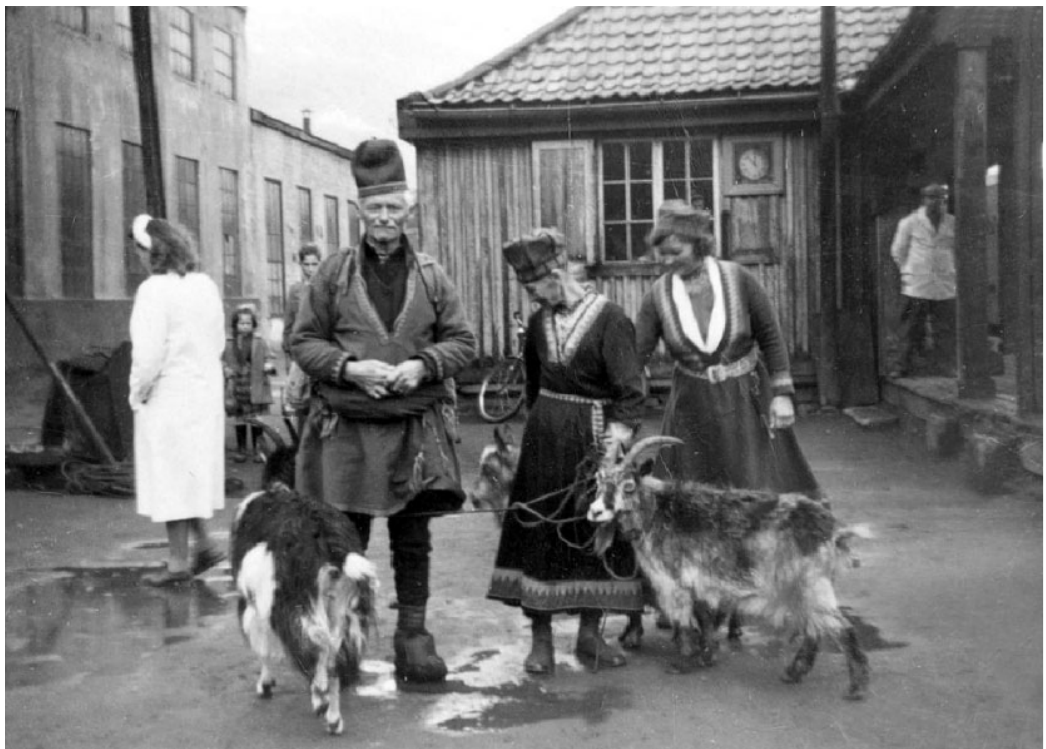
Fig. 5. Fall in the industrial town of Sulitjelma, Nordland County, from around 1950. The Steggo family is ready to hand over their goats to custody for the winter before leaving for Mavas Luokta, Norrbotten County, Sweden. Photo: From Evjen,